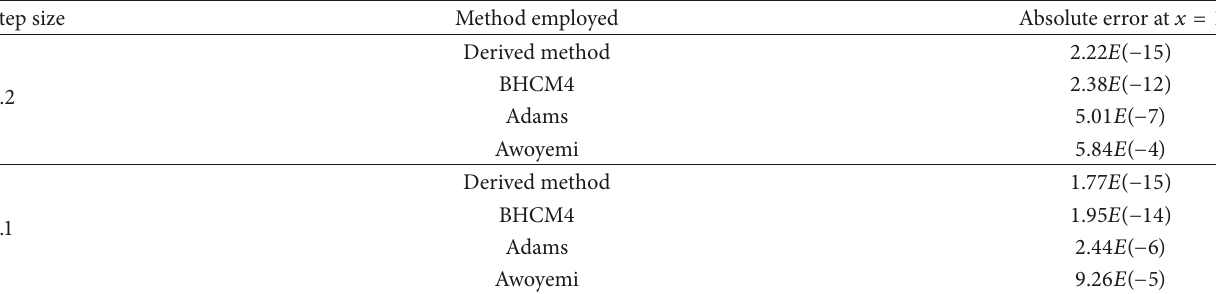
Table 3: Comparison of the derived method with [15, 17] and Adams Bashforth-Adams Moulton method.